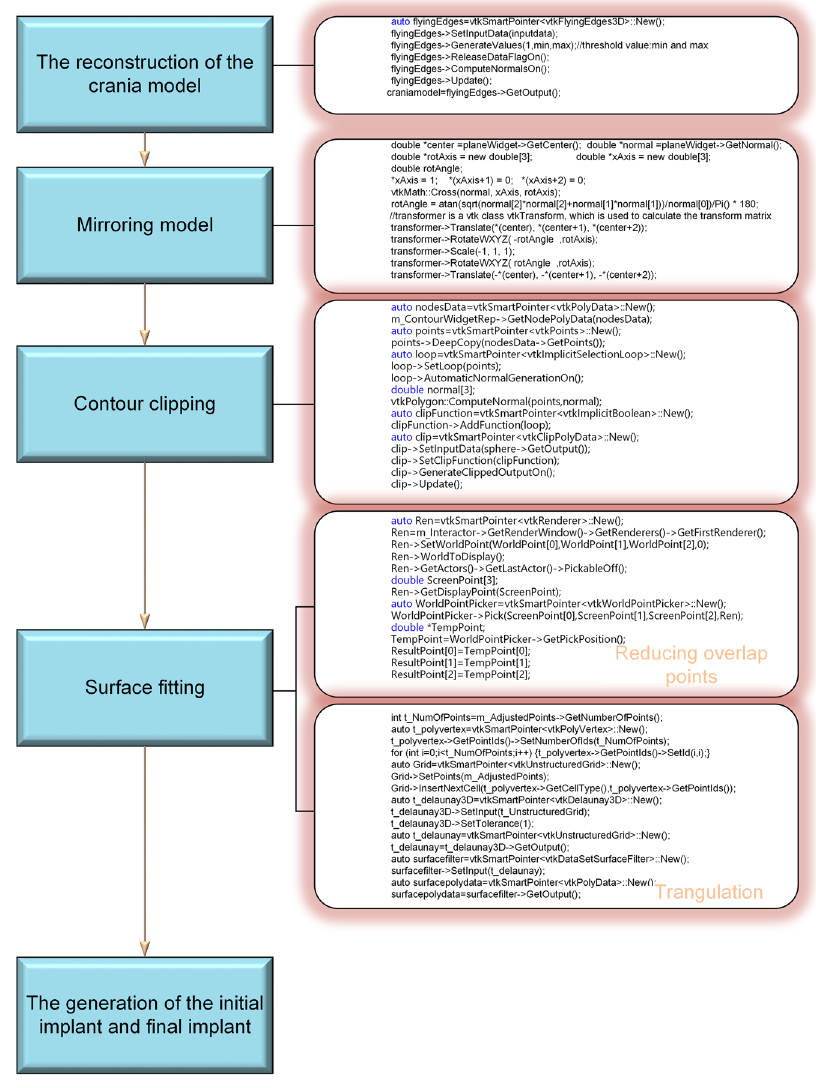
Figure 7. The architecture of